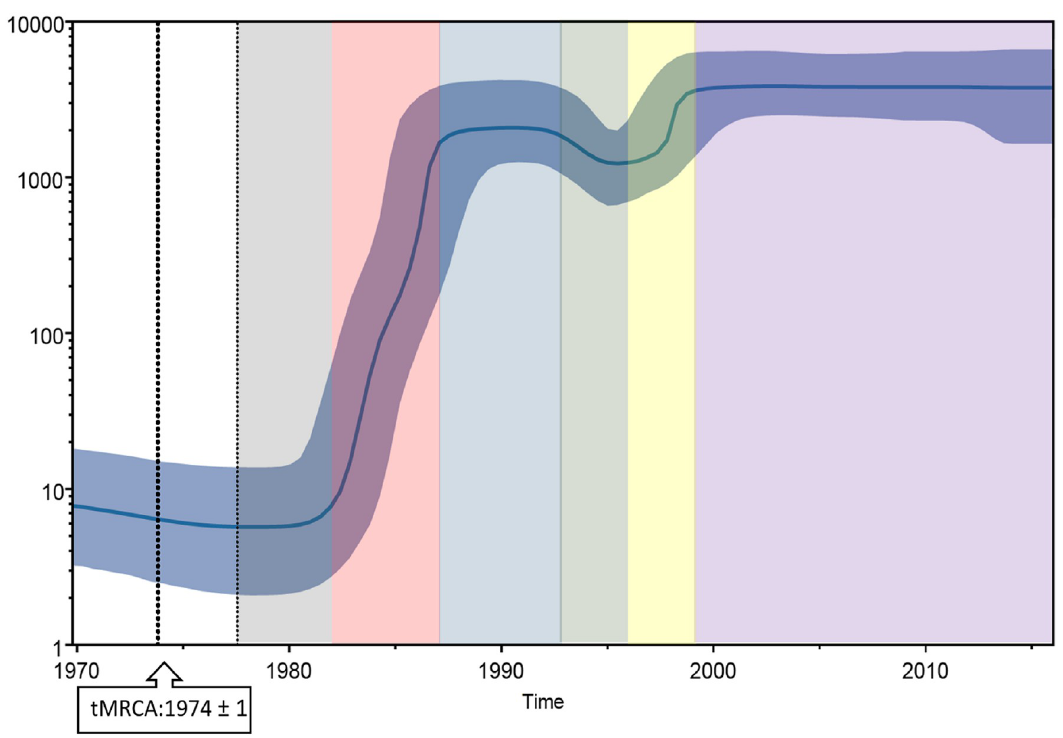
Fig 3. HIV-1 CRF01_AE gag gene effective population size and time to the most recent common ancestor. Bayesian Skyline plot, based on a ‘relaxed clock’ coalescent framework analysis, was constructed using 286 sequences (representing all years and countries). The X-axis represents time in years, while Y-axis shows an effective population size. The thick black line represents the median, while the blue band represents 95% highest posterior density (HPD) intervals. The tMRCA of the HIV-1 subtype AE gag gene is indicated by a black dotted line and a black box. Grey, red, blue, green, yellow, and purple shaded areas represent the period of the plateau phase, increase in viral effective population size, plateau phase, decline, increase, and plateau,